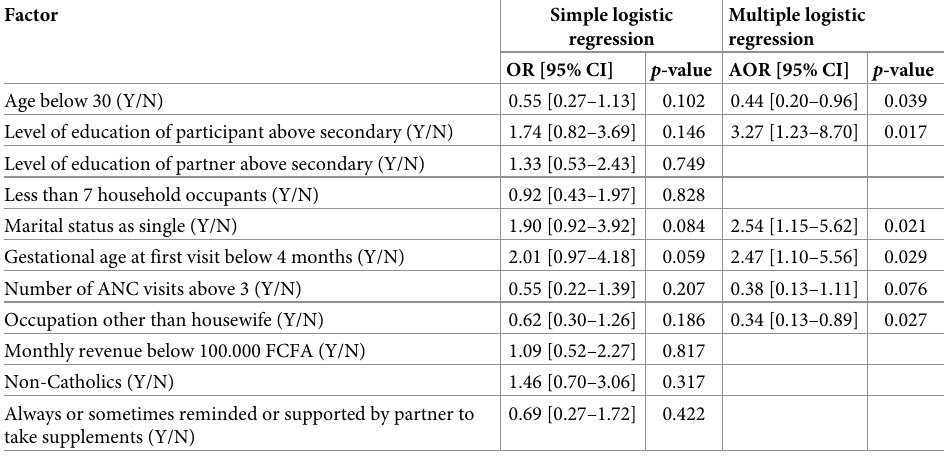
Table 5. Sociodemographic and obstetric factors associated with ionised hypocalcaemia.